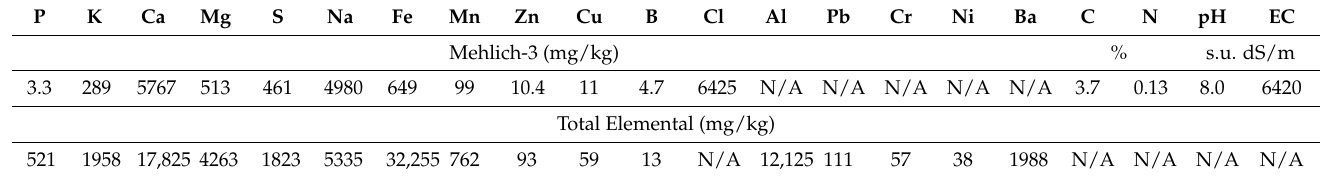
Table 3. The pH, total, and Mehlich-3 extractable elemental levels, % total N and C, and Cl levels of soil from a drained drilling fluid and produced water settling pond. Mean of two soil composite samples collected from a drilling fluid and produced water settling